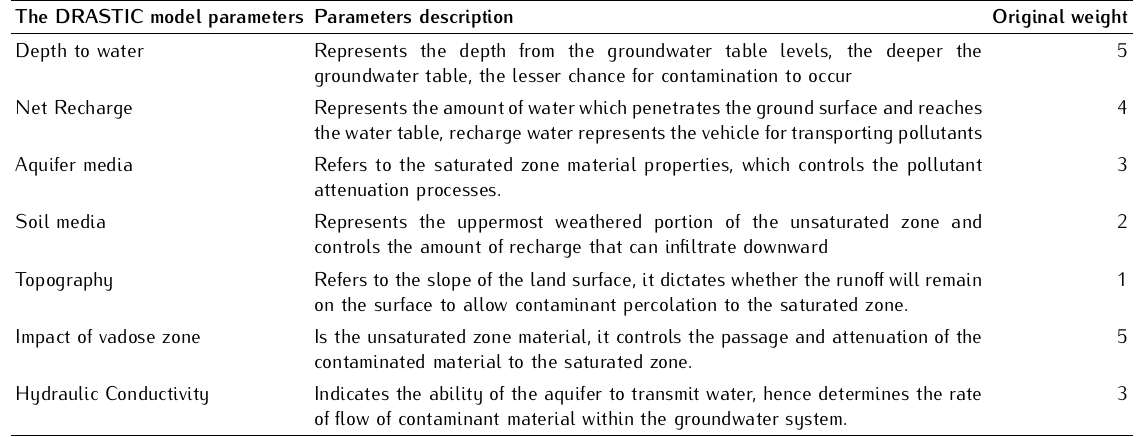
Table 3. Description and original weights of the intrinsic and specific model parameters [32].